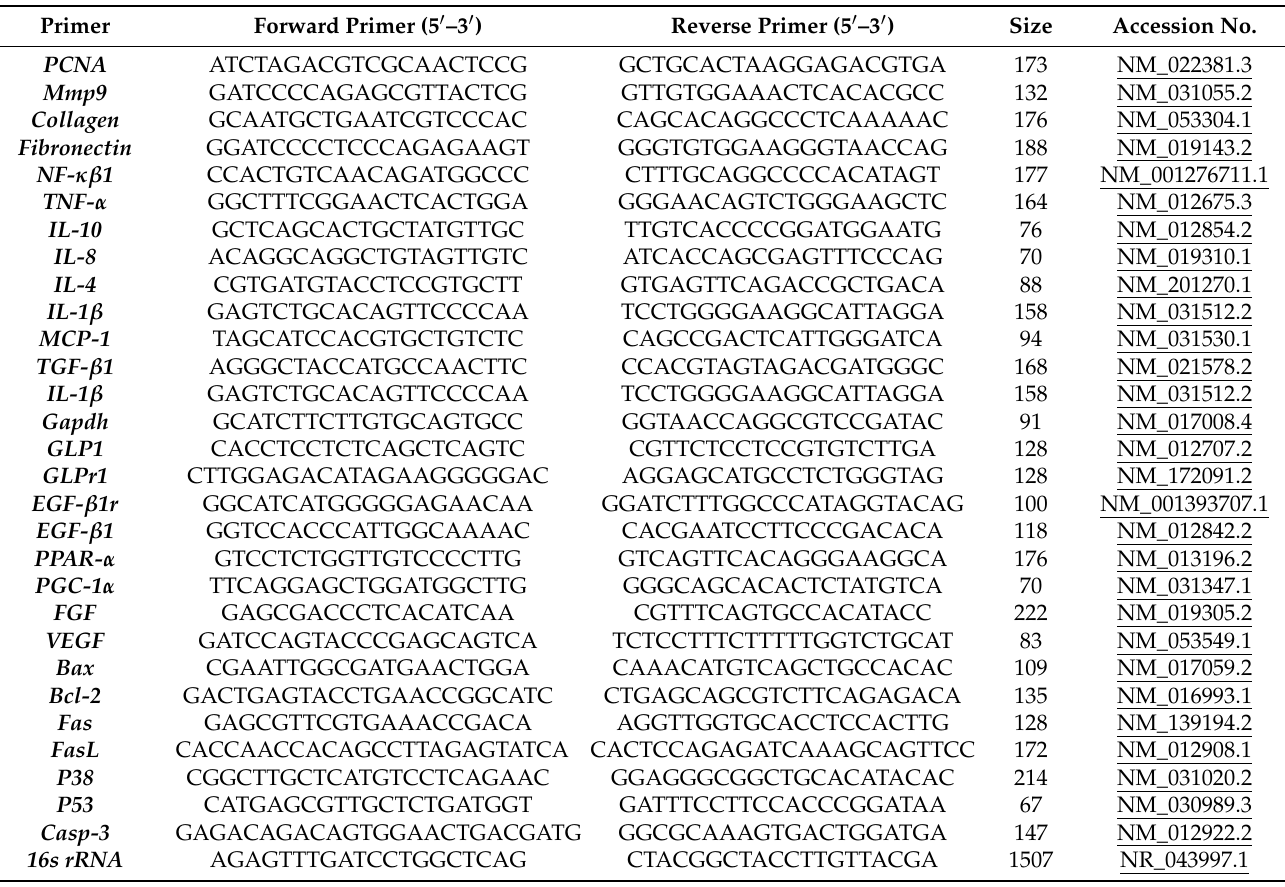
Table 4. Primers sequence used and their